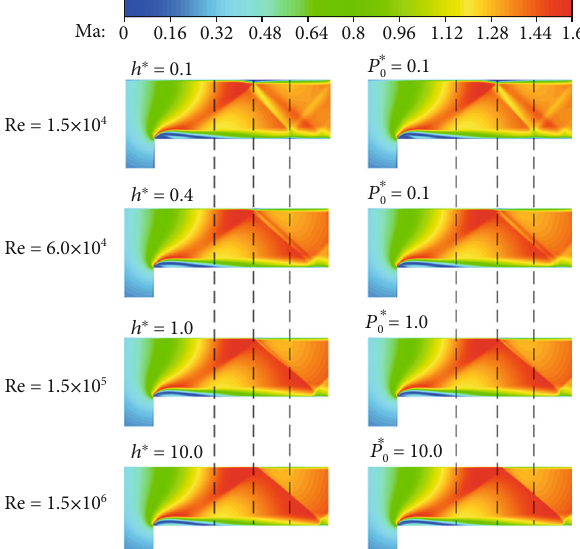
Figure 11: Mach number contours for di ff erent gap sizes and total pressure